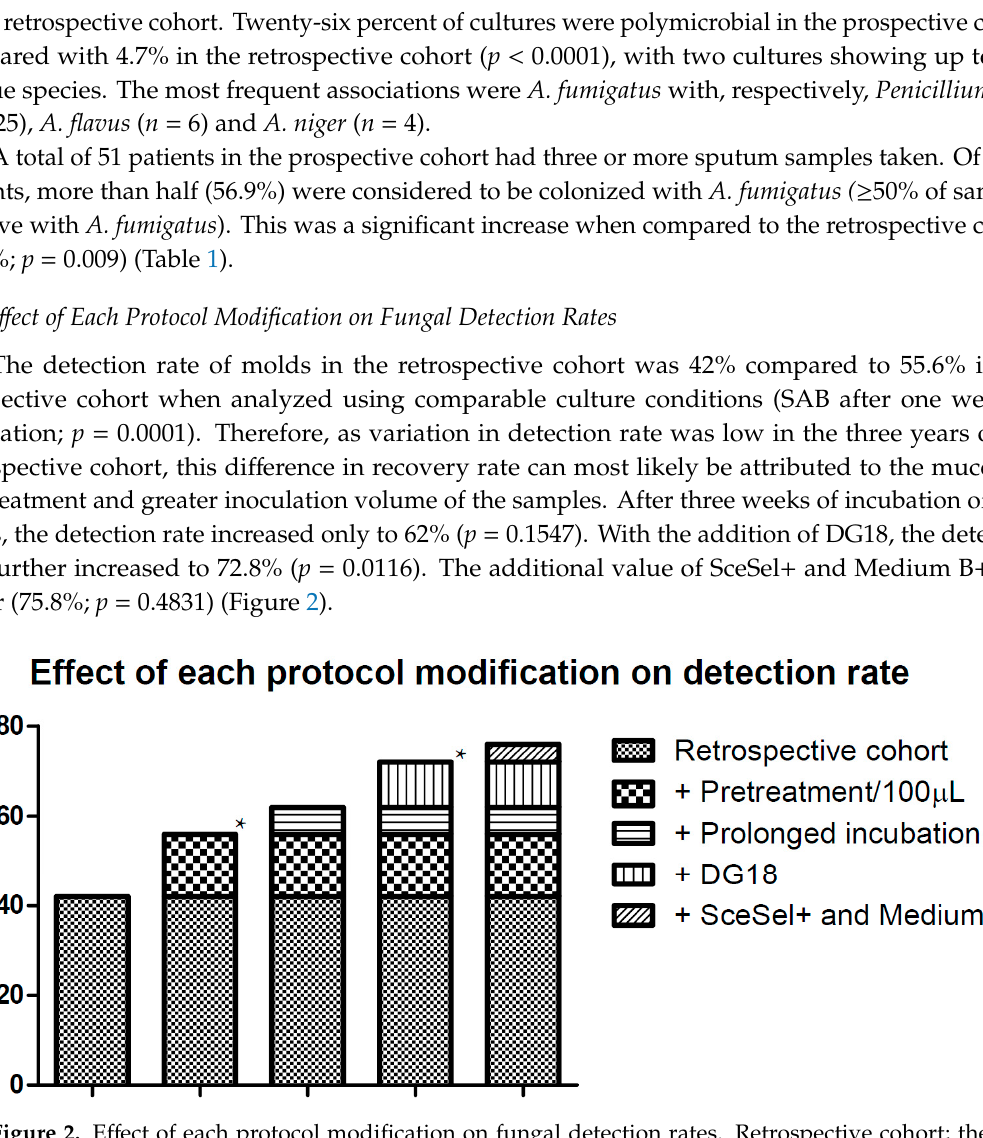
Figure 2. Effect of each protocol modification on fungal detection rates. Retrospective cohort; the detection rate of any mold of the retrospective cohort + Pretreatment/100 μ L; the detection rate of prospective cohort after 1 week of incubation on Sabouraud (SAB) with mucolytic pretreatment and inoculation of 100 μ L sputa + Prolonged incubation; the detection rate after 3 weeks of incubation on SAB with mucolytic pretreatment and the inoculation of 100 μ L sputa + DG18; the detection rate after 3 weeks of incubation on SAB and Dichloran-Glycerol Agar (DG18) with mucolytic pretreatment and inoculation of 100 μ L sputa + SceSel+ and Medium B+; the detection rate after 3 weeks of incubation on SAB, DG18, Scedosporium selective agar (SceSel+) and medium B+ with mucolytic pretreatment and inoculation of 100 μ L sputa. * Significant increase compared to the previous column.